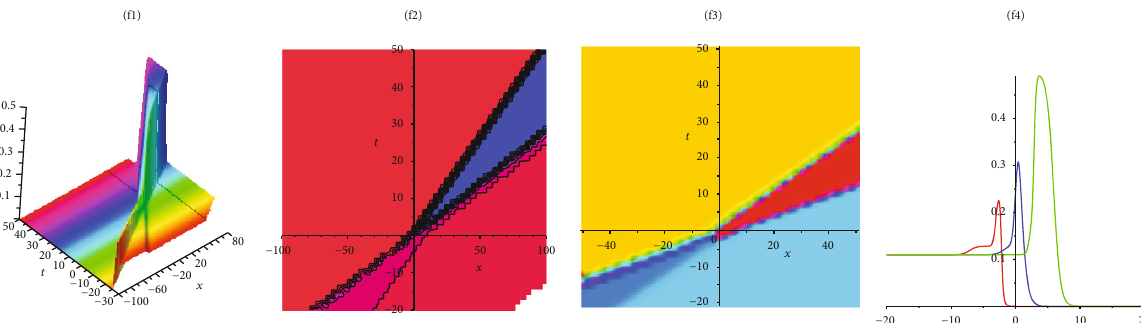
Figure 11: The two-wave solution (55) at α = 0 : 5, β = 0 : 1, α δ = 0 : 5, δ 2